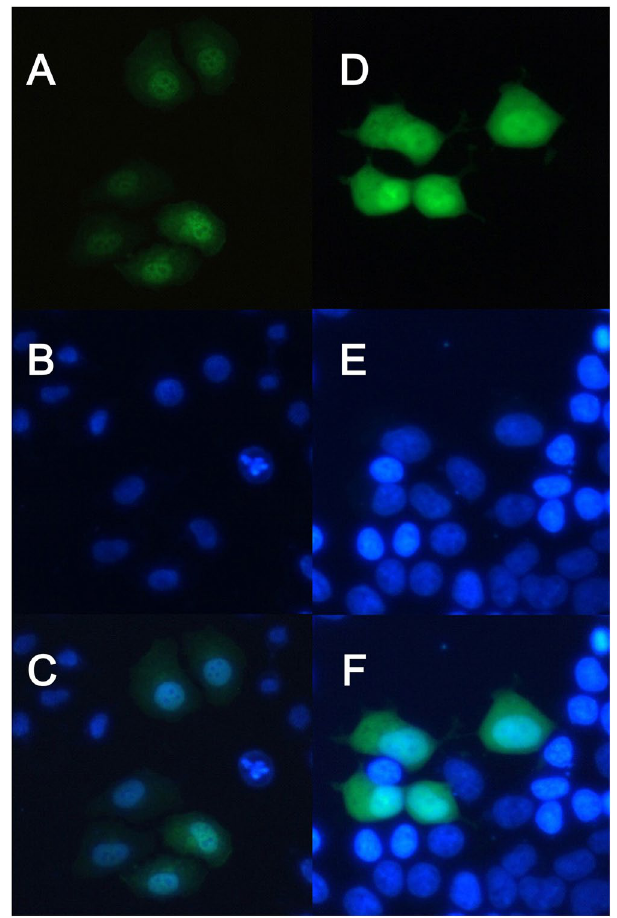
Figure 6. Distribution of GFP-tagged Gal-13 in HeLa and 293 T cells. ( A ) Following transfection, GFP-tagged Gal-13 was found to be distributed in the cytoplasm and nucleus. This protein was mainly localized within the nucleus of HeLa cells. There are 4–6 dark areas in the nucleus. ( B ) The nucleus of HeLa cells was stained by Hoechst. ( C ) Merge of ( A ) and ( B ). Similar experiments were performed using 293 T cells. ( D ) The GFP-tagged Gal-13 in 293 T cells is visualized. ( E ) The 293 T cell nuclei were stained using Hoechst. ( F ) Merge of ( D ) and ( E ).